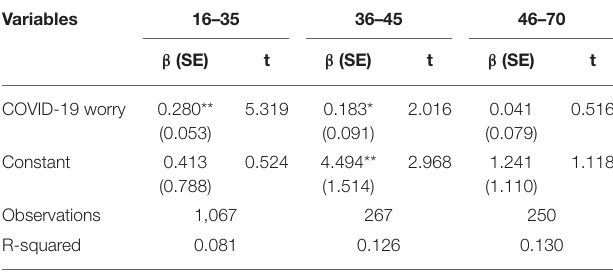
TABLE 5 | Effect of COVID-19 worry on mental health, by age.